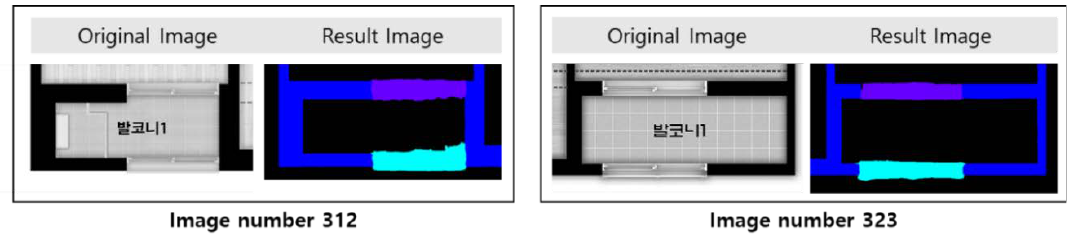
Figure 9. Slidingdoor and window, which are difficult to distinguish by form, were accurately inferred.